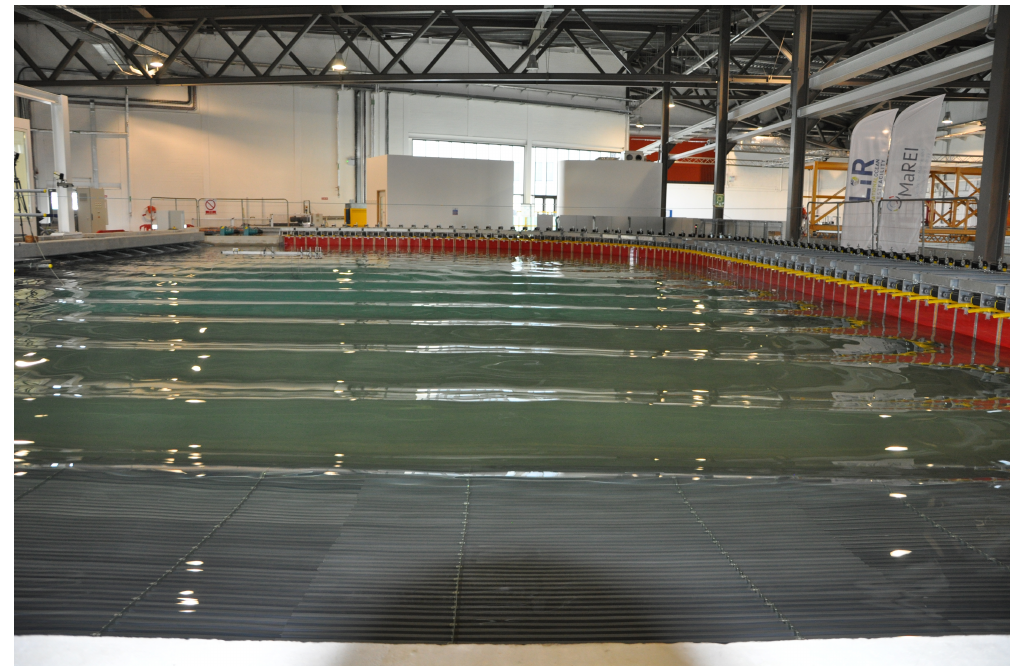
Figure 1. Ocean basin in LIR National Ocean Test Facility in Cork, Ireland